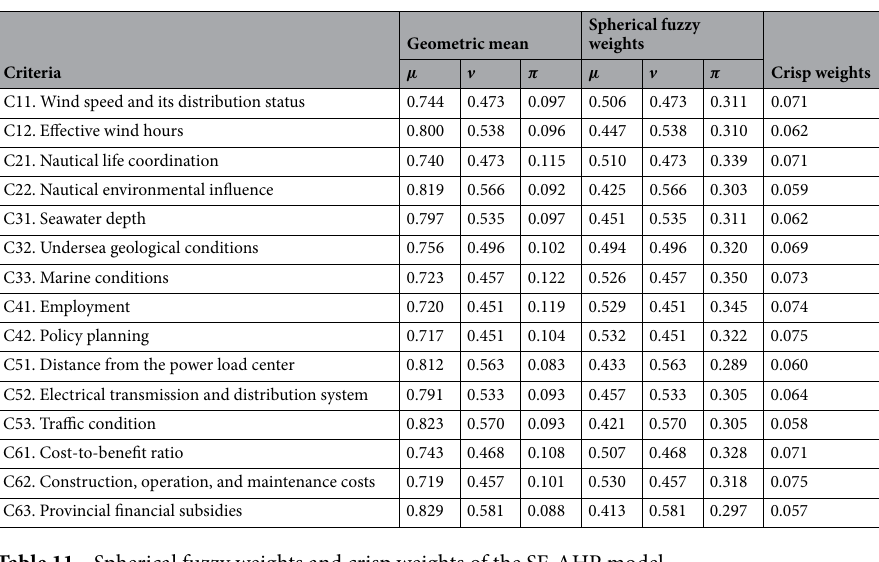
Table 11. Spherical fuzzy weights and crisp weights of the SF-AHP model.